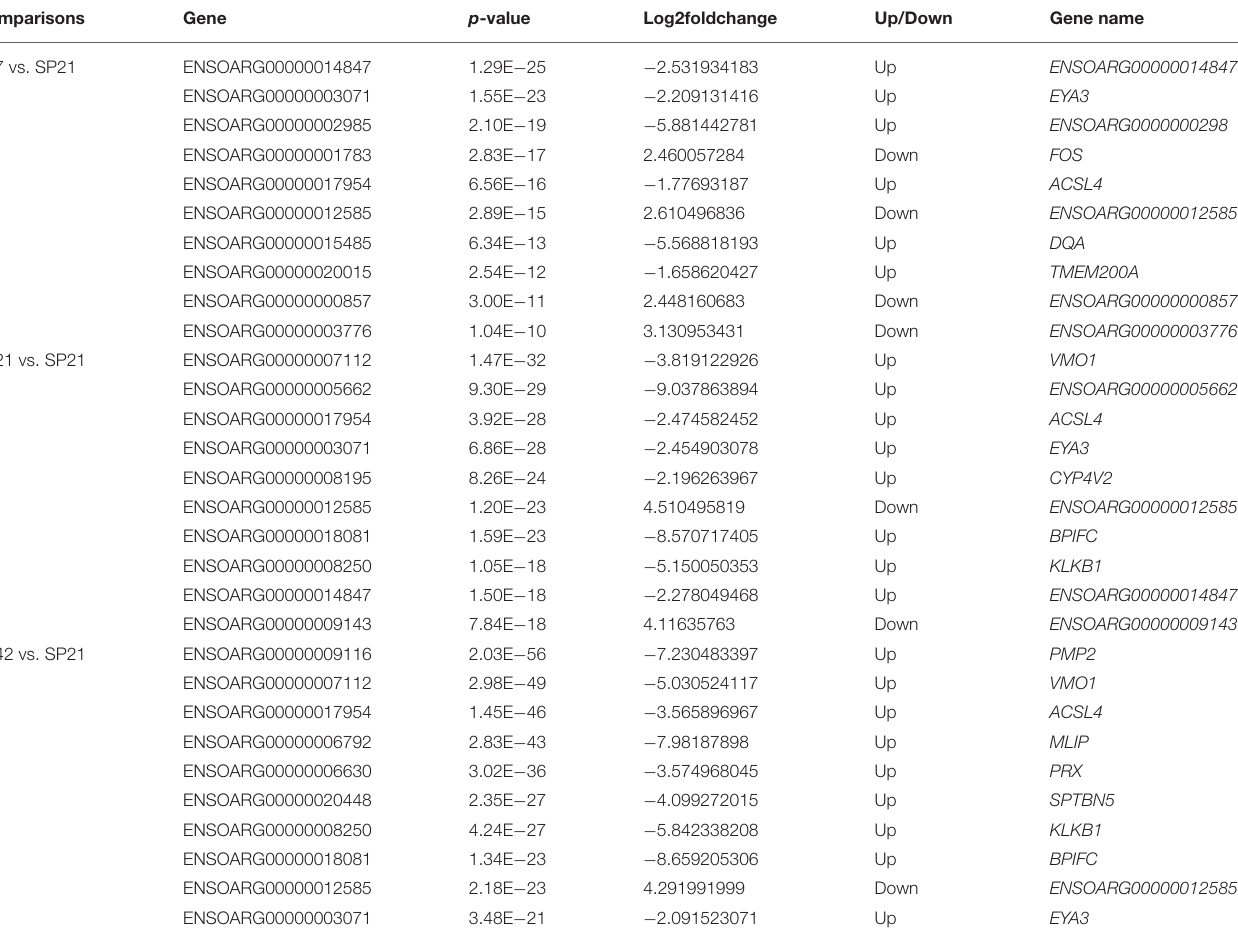
TABLE 2 | The top 10 differentially expressed mRNAs in three comparisons between LP and SP.